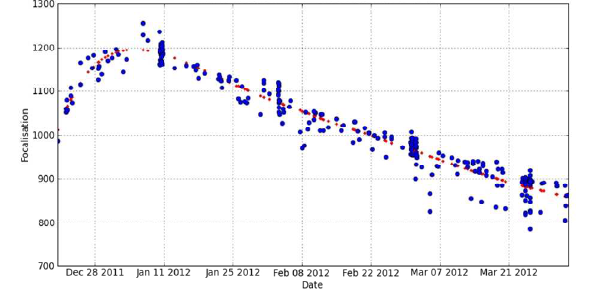
Figure 5 : defocus evolution between launch and April